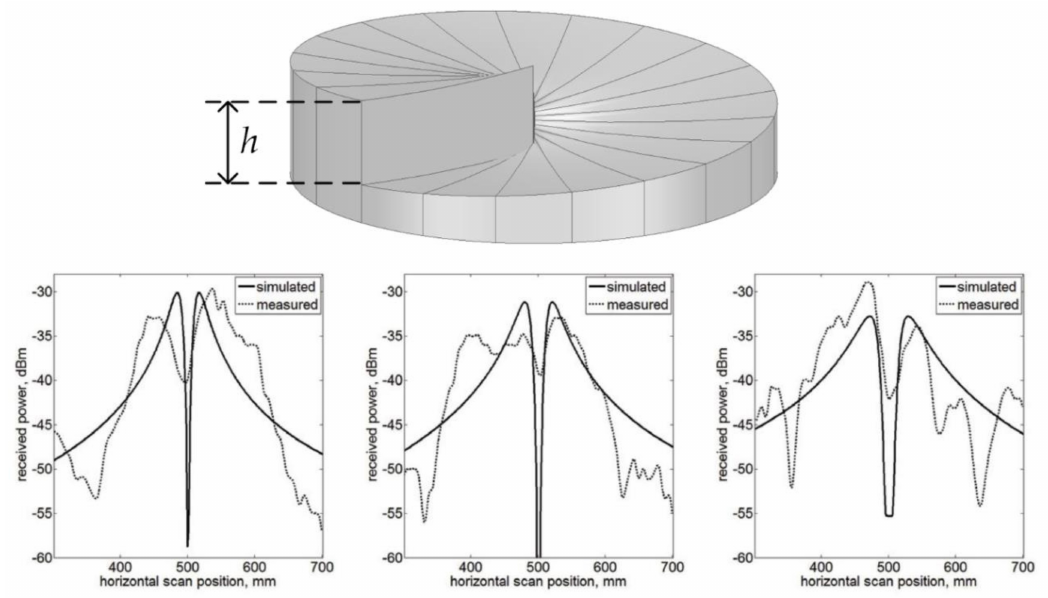
Figure 2. Schematic design of a spiral phase plate and results obtained at 60 GHz in